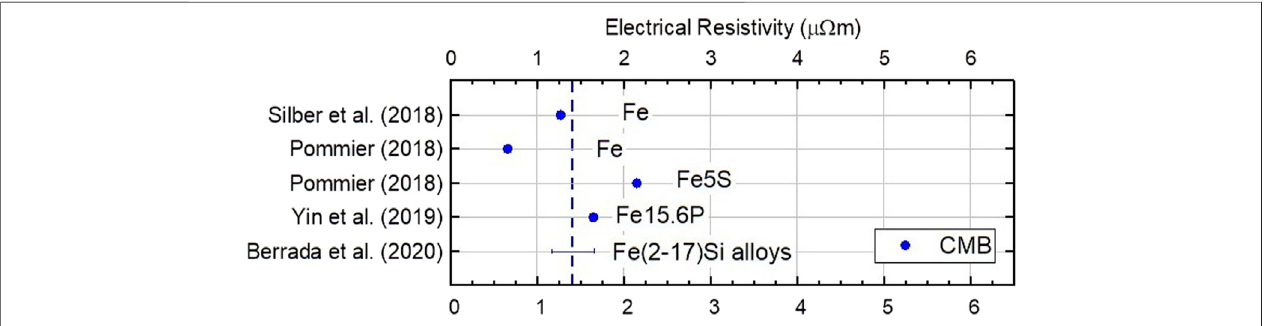
FIGURE3| Combined values of ρ from theliterature applied totheMoon ’ scorepresentedindateorder.Theblue dashed linerepresentstheaveragevaluesat the CMB. The average of all reported values at CMB (1,687 – 1,800 K, 4.5 GPa) conditions is 1.40 µ Ω m. Repeated references indicate different compositions.